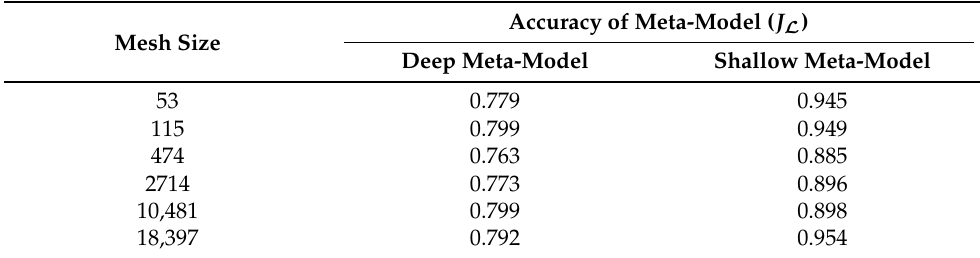
Table 1. Comparison of accuracy of meta-models for models on different mesh sizes. Mesh